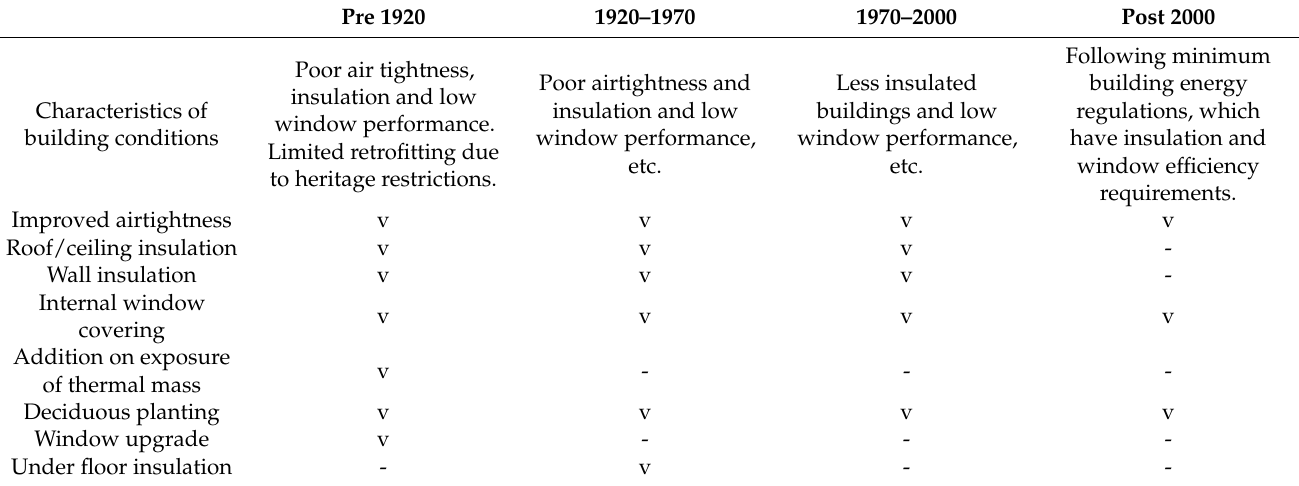
Table 2. Potential retrofit options to reduce energy and GHG emissions in residential buildings in